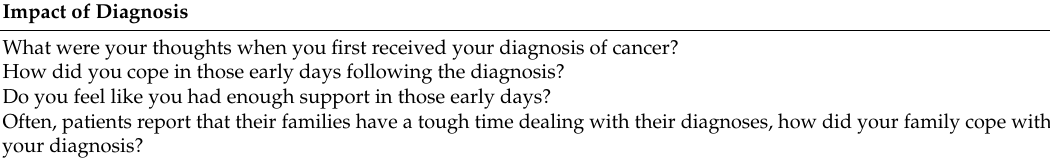
Table 1. Semi-structured interview guide to gauge patient experiences and facilitating factors for positive cancer